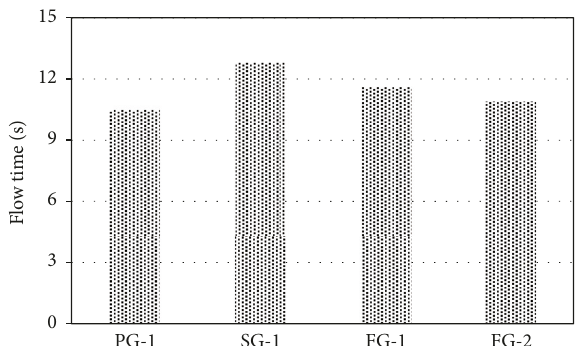
Figure 3: Flow time according to the cement grout mixtures.